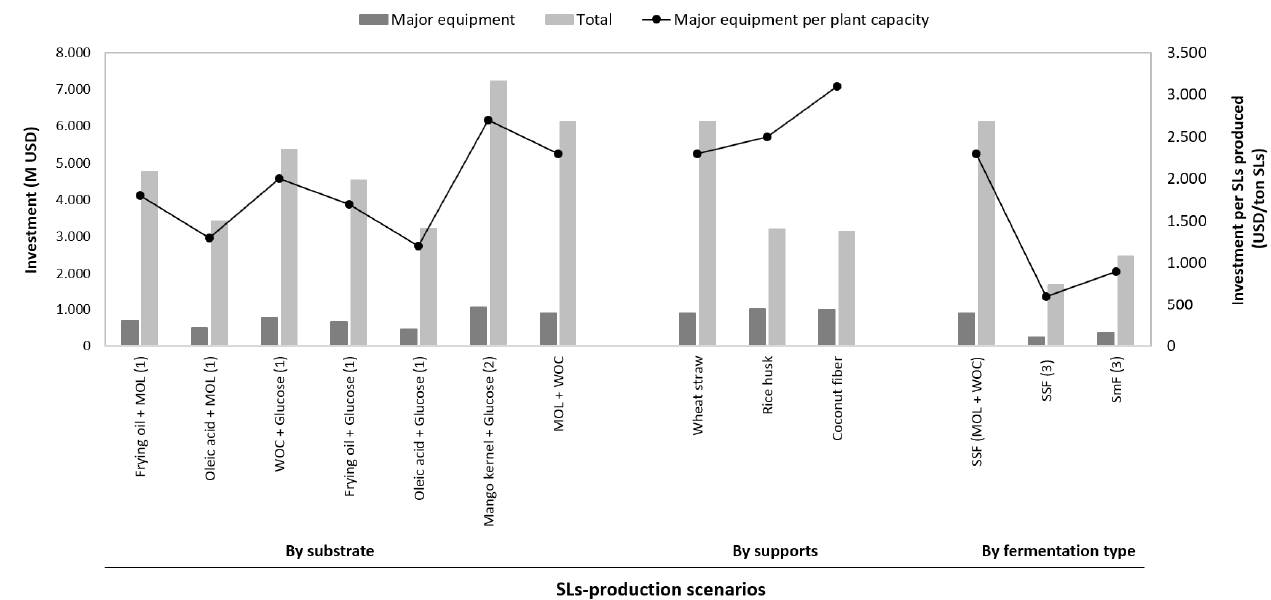
Figure 6. Investment of the studied cases for SL production by different substrates, supports and technology. (1) Jim é nez-Peñalver et al. [41]; (2) Parekh et al. [25]; (3) Rashad et al.,